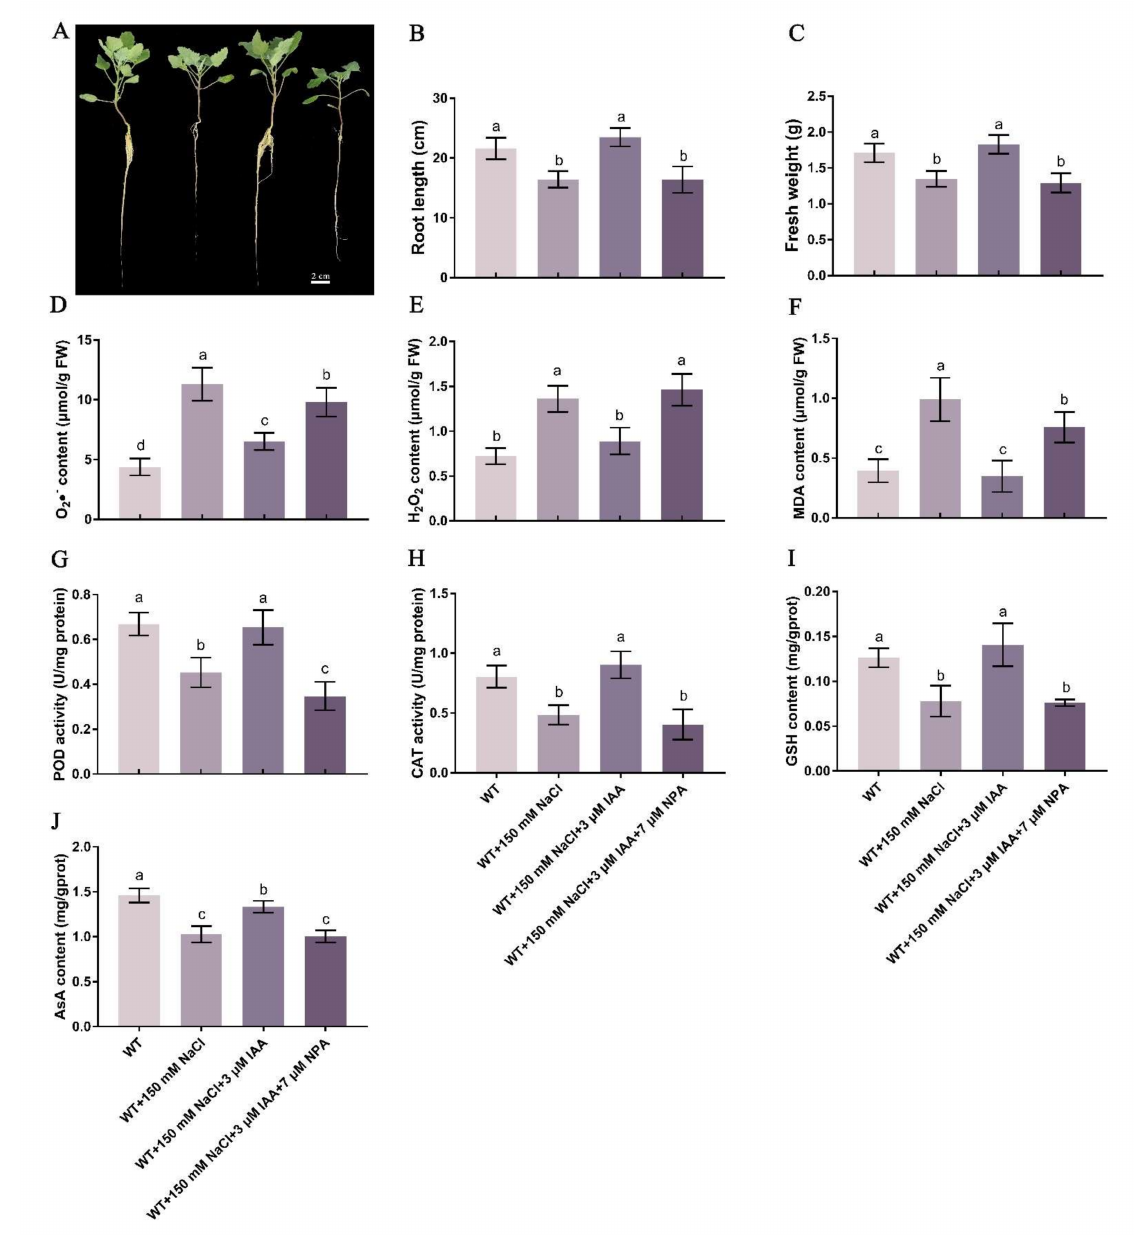
Figure 1. Effect of IAA on the growth and antioxidant capacity of quinoa roots under salt stress. Quinoa seedlings of six true leaves were cultured in Hoagland solution (CK), 150 mM NaCl-Hoagland solution, 150 mM NaCl + 3 µ M IAA-Hoagland solution and 150 mM NaCl + 3 µ M IAA + 7 µ M NPA-Hoagland solution for two weeks and then phenotype, root length and fresh weight were recorded. ( A ) Phenotypic changes in quinoa seedlings under different treatments. Bar = 2 cm; ( B ) The root length; ( C ) The fresh weight. ( D ) O2 • − content in roots; ( E ) H 2 O 2 content in roots; ( F ) MDA content in roots. ( G ) POD activity in roots; ( H ) CAT activity in roots. ( I ) GSH content in roots; ( J ) ASA content in roots. Values are mean ± SD ( n = 3). Different letters (a–d) in Figure 1B − J indicate significant differences at p < 0.05 according to one-way ANOVA (comparing the mean of each column with the mean of every other column) in GraphPad Prism